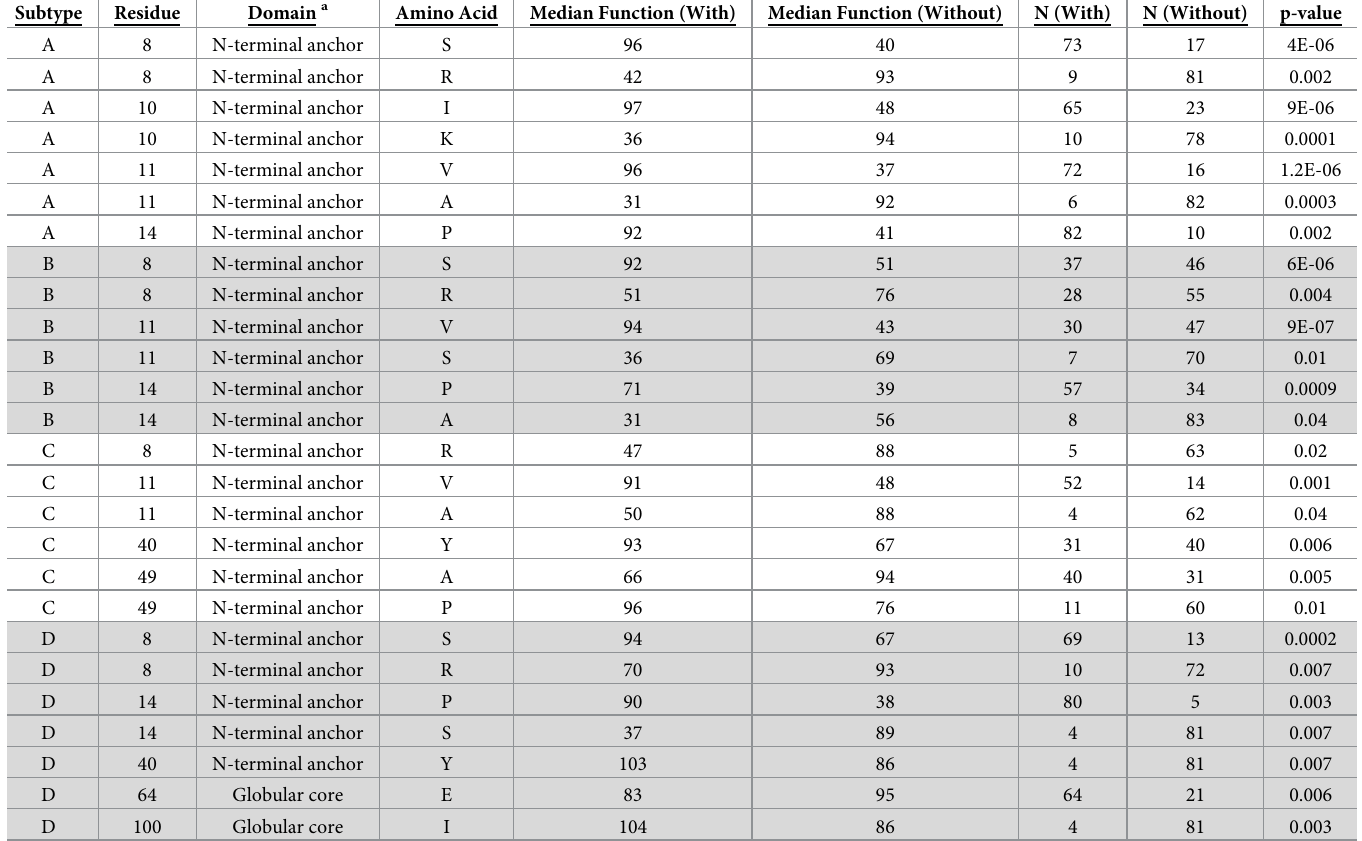
Table 2. Selected Nef polymorphisms associated with SERINC3 internalization